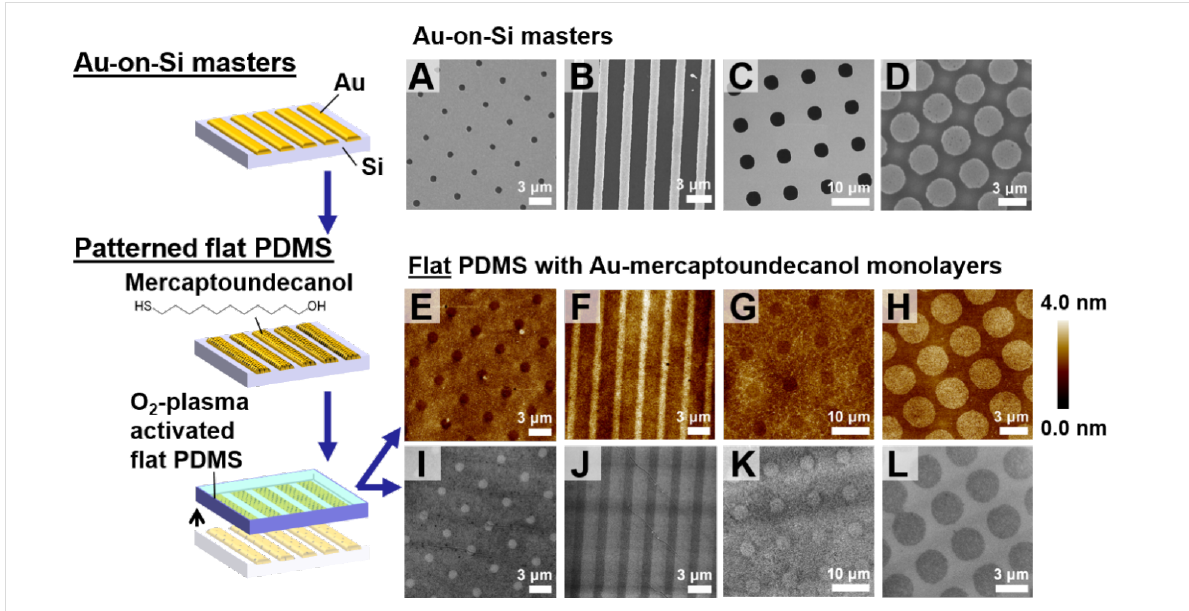
Figure 1: (Left) Scheme for patterning flat poly(dimethylsiloxane) (PDMS) substrates with Au–mercaptoundecanol monolayers. The Au features (100 nm height) on the Au-on-Si masters were functionalized with mercaptoundecanol and contacted with topographically flat PDMS stamps. (A–D) Scanning electron micrographs of Au-on-Si masters with (A) 1 μ m diameter holes, (B) 1 μ m lines, (C) 5 μ m diameter holes, and (D) 3 μ m diam- eter raised circles. The Au regions appear bright in these images. (E–H) Height maps of Au–mercaptoundecanol monolayers on PDMS produced from the Au masters in panels A–D, respectively. Images were acquired by peak-force atomic force microscopy. (I–L) Variable-pressure scanning electron micrographs of the same Au–alkanethiolate patterns on PDMS visualized in panels E–H. Images in panels I–L are contrast-enhanced to visu- alize the features more clearly. The original images are shown in Figure S2 (Supporting Information File